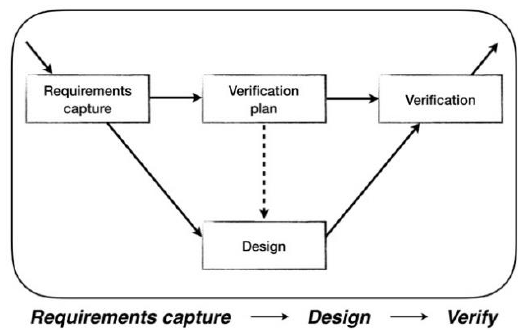
Figure 1. Generic verification V model (inspired by Reference [52]).